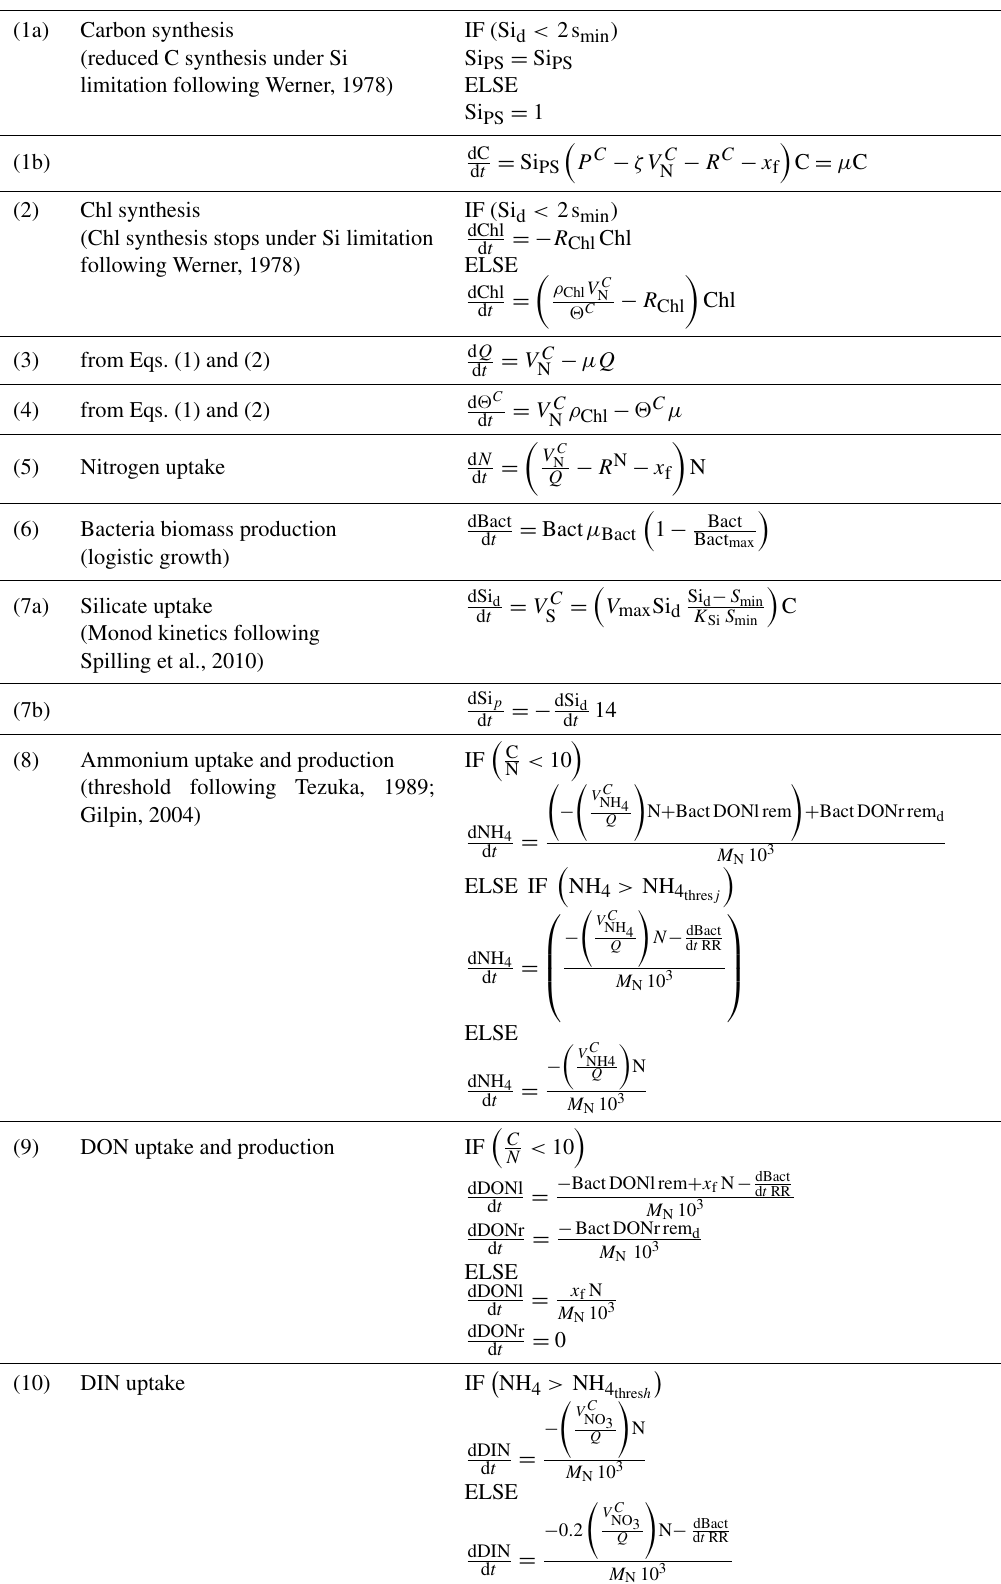
Table A7. Model equations of the EXT model based on